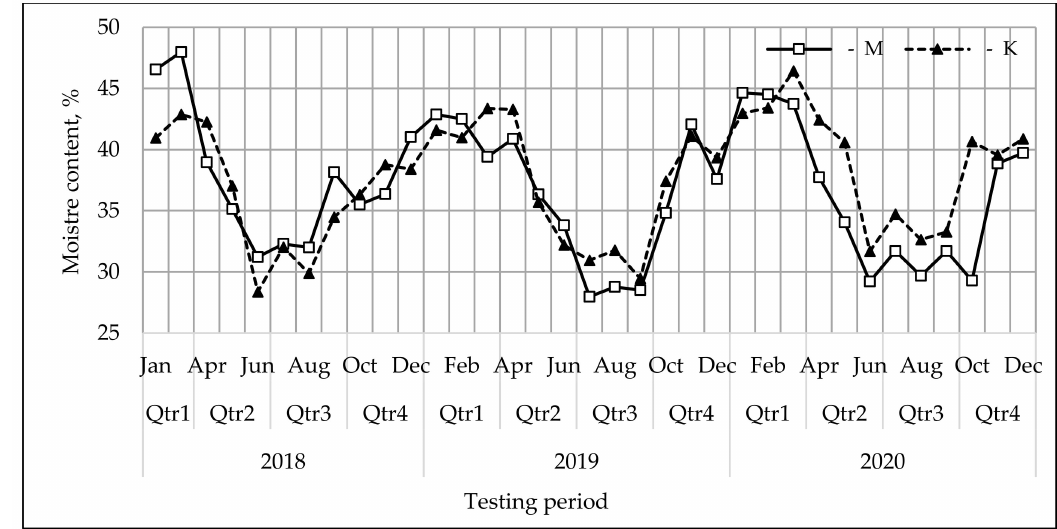
Figure 3. Monthly average values of moisture content of wood chips supplied to companies M and K.